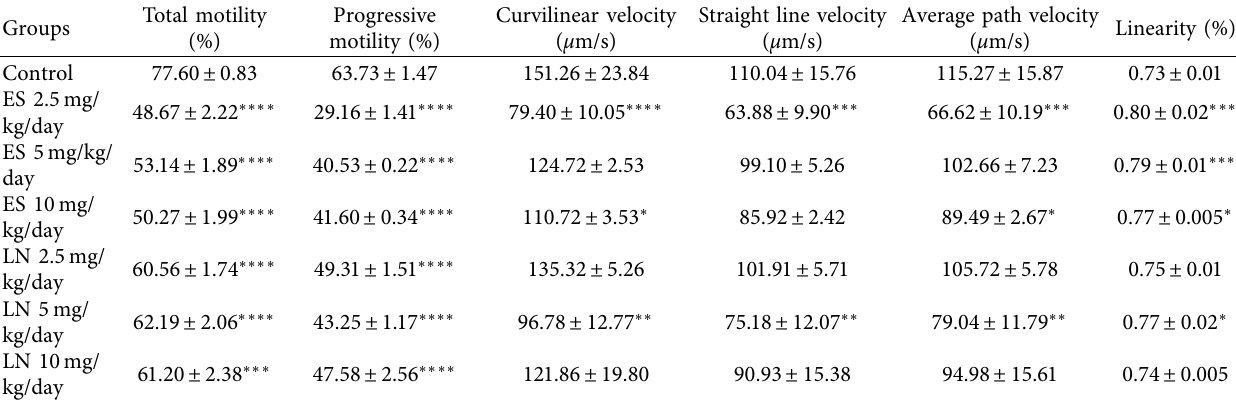
Table 1: Effect of treatment with esomeprazole (ES) and lansoprazole (LN) on sperm motility in male rats.